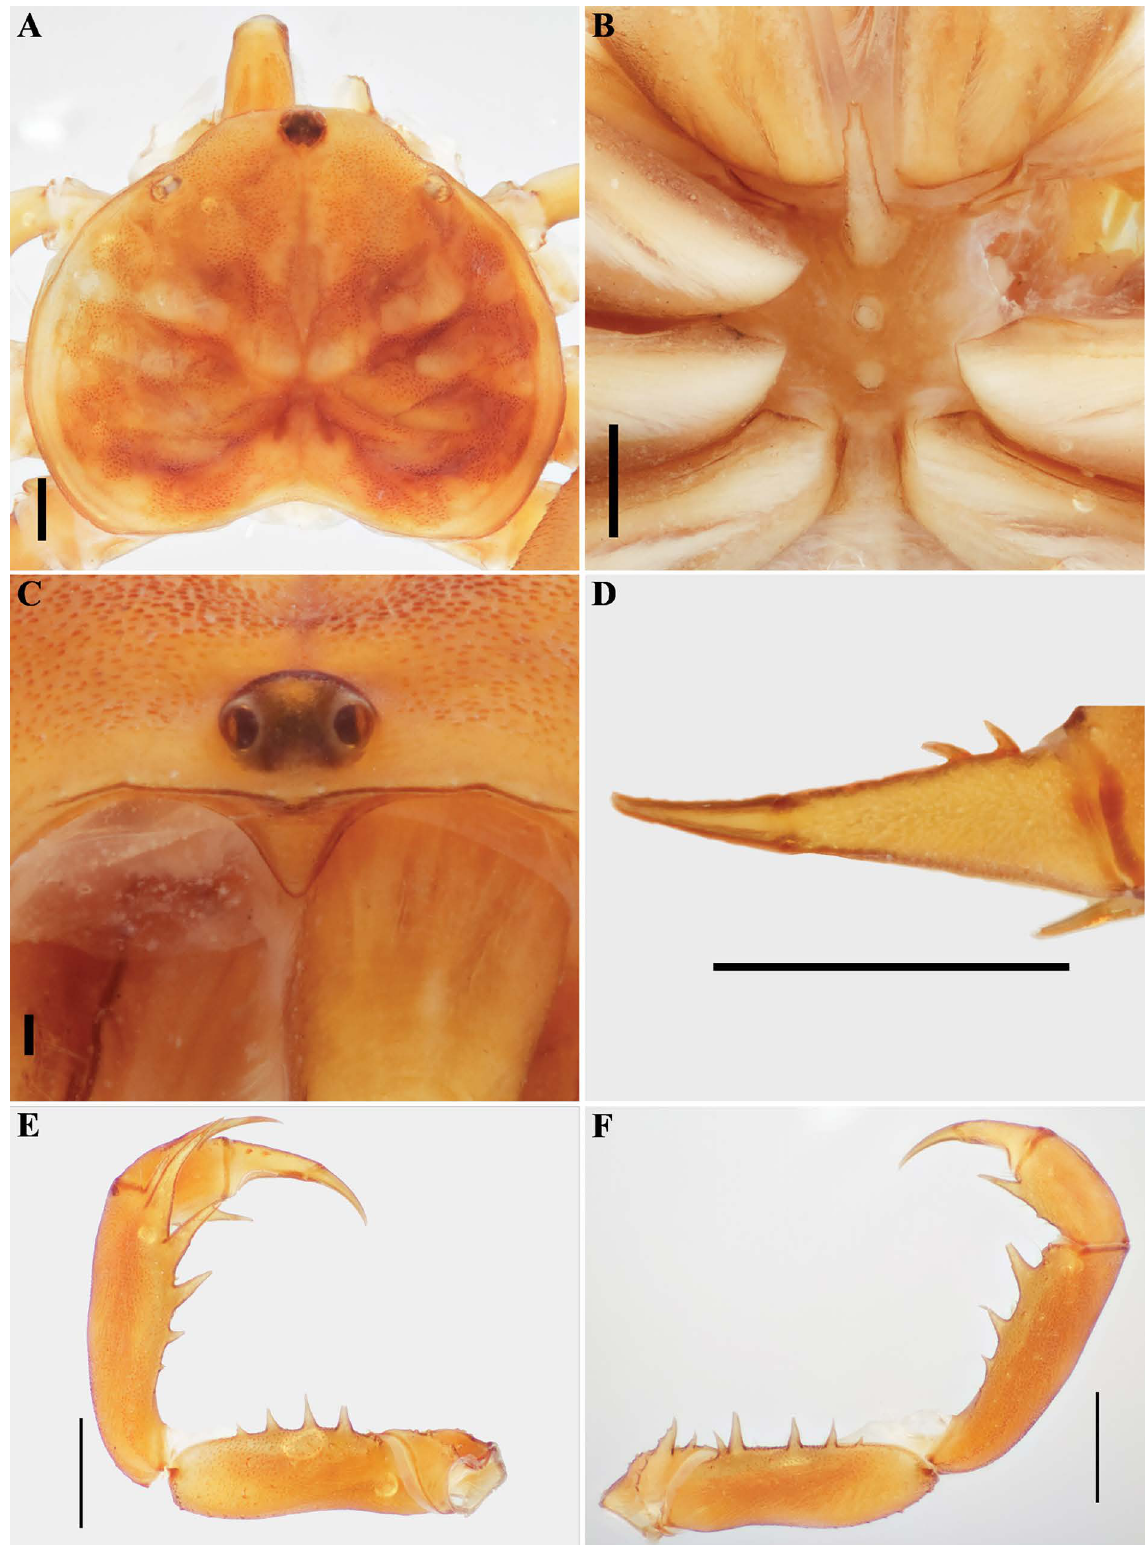
Fig. 130. Sarax willeyi Gravely, 1915 (SMF), general morphology, ♀. A . Carapace, dorsal